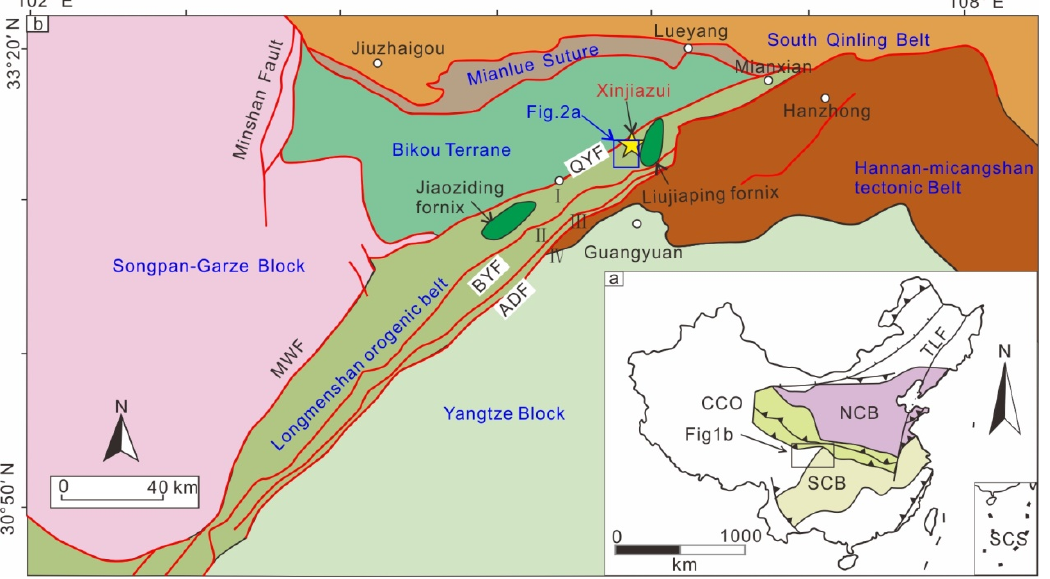
Figure 1. Simplified geotectonic map of the Longmenshan orogenic belt [37,42,43]. ( a ): regional geological map of the Longmenshan tectonic belt and its adjacent areas; ( b ): the schematic tectonic map of China and the location of the Longmenshan Orogen. Notes: I. Back Longmenshan orogenic belt; II. front Longmenshan fold and thrust belt; III. Anxian–Dujiangyan fault zone; IV. foreland fold belt. Abbreviations: CCO: Center China Orogen; NCB: North China Block; SCB: South China Block; SCS, South China Sea; TLF: Tancheng–Lujiang Fault; ADF: Anxian–Dujiangyan fault; BYF: Beichuan–Yingxiu fault; QYF: Qingchuan–Yangpingguan fault.